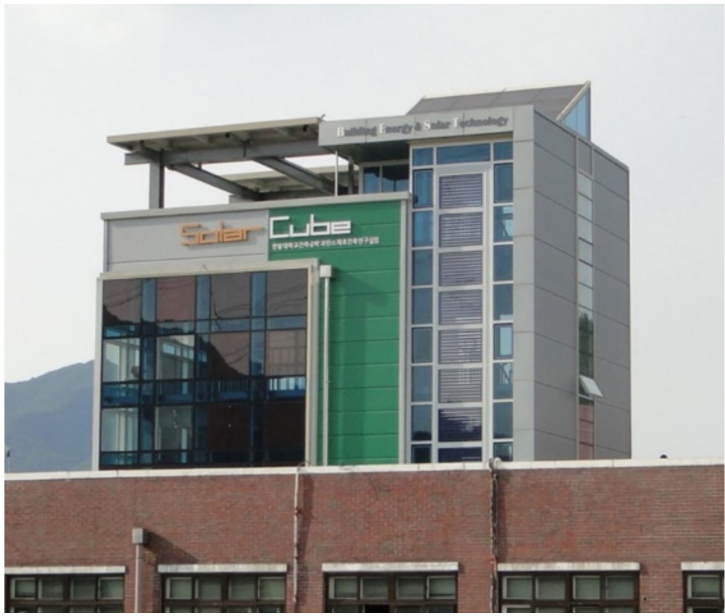
Figure 1. View of the building integrated photovoltaic (BIPV) test